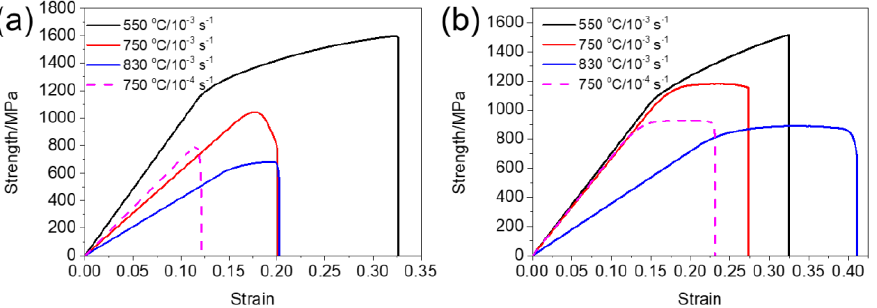
Figure 4. Stress – strain curves for SL ( a ) and SH ( b ) between 550 °C and 830 °C under different Figure 4. Stress–strain curves for SL ( a ) and SH ( b ) between 550 ◦ C and 830 ◦ C under different strain rates. strain